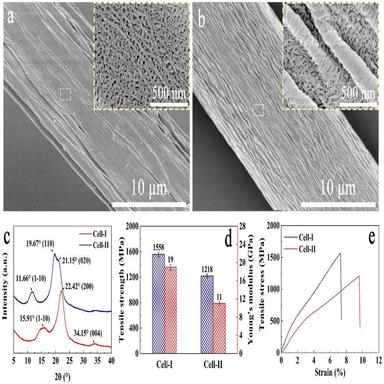
Morphology, structure, and mechanical properties of cellulose I and cellulose II. Scanning electron microscopy (SEM) image and surface magnification of (a) Cell-I and (b) Cell-II. (c) X-ray diffraction (XRD) patterns, (d) tensile strength, and (e) tensile stress–strain curves of Cell-I and Cell-II.